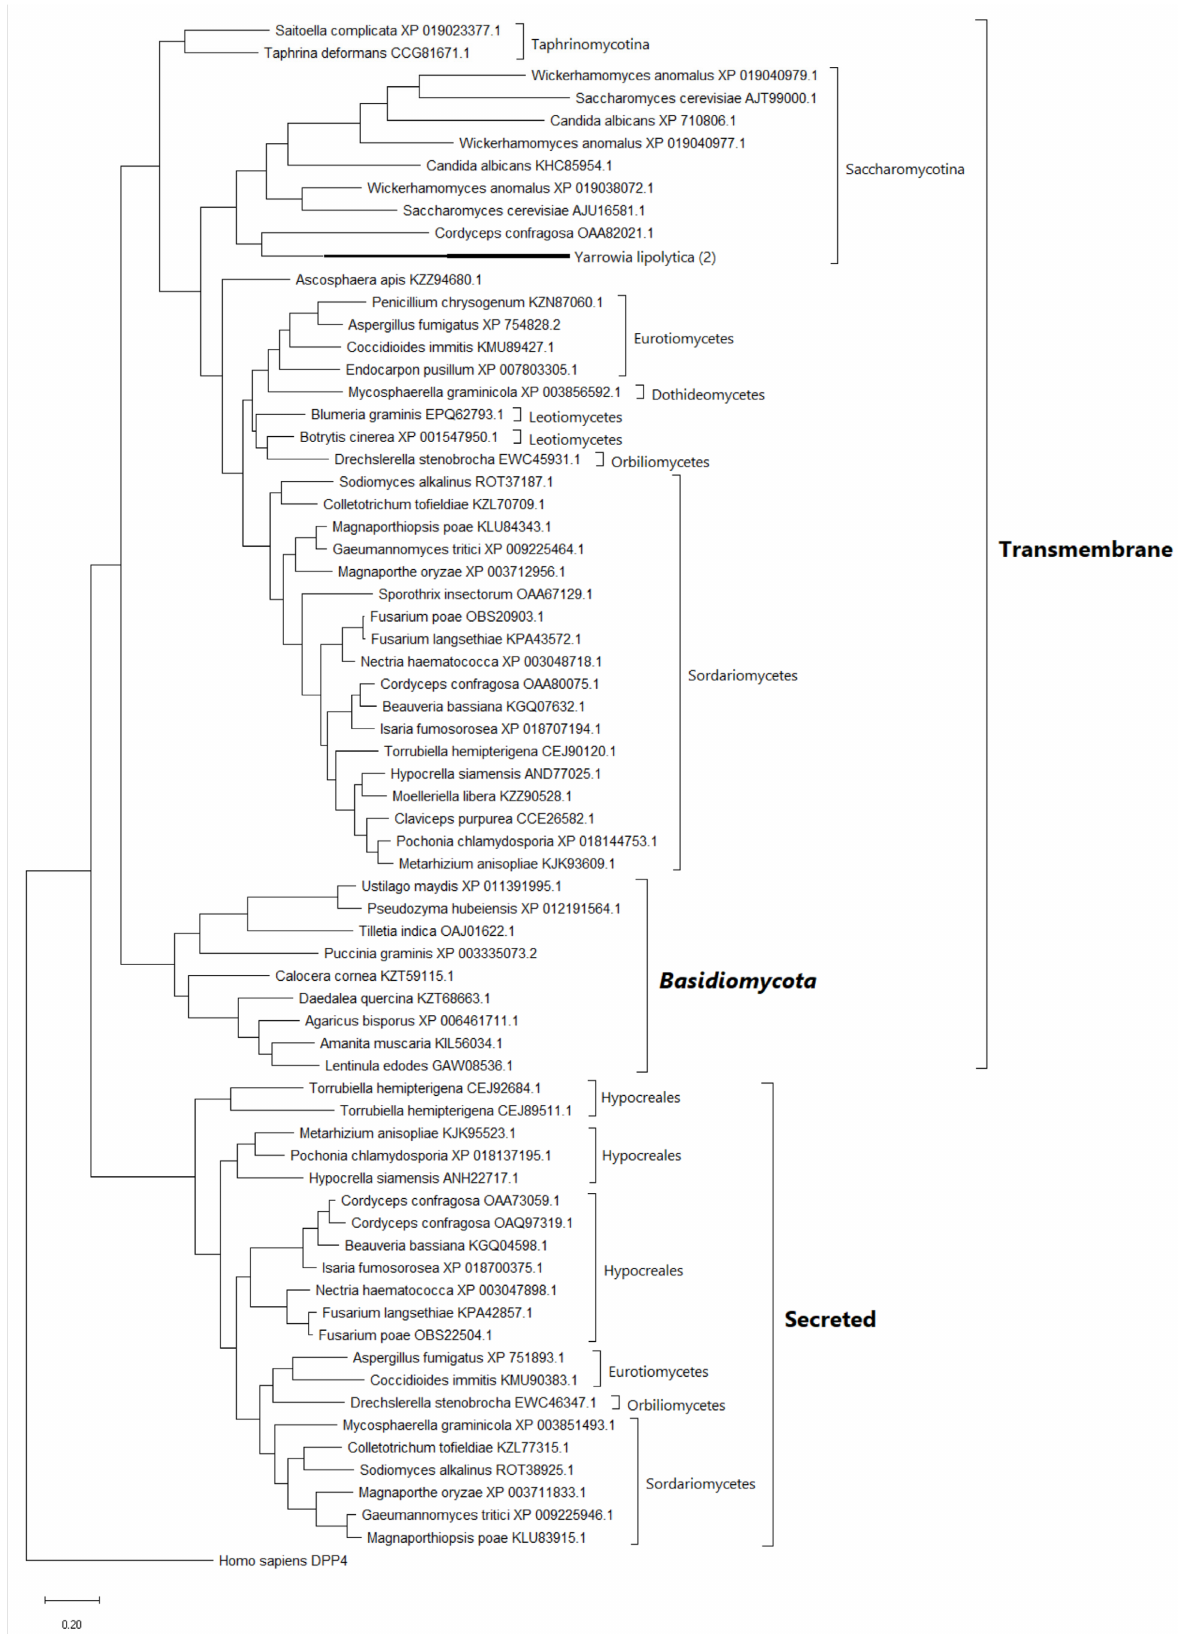
Figure 2. The cladogram of DPP4 homologs constructed by the ML